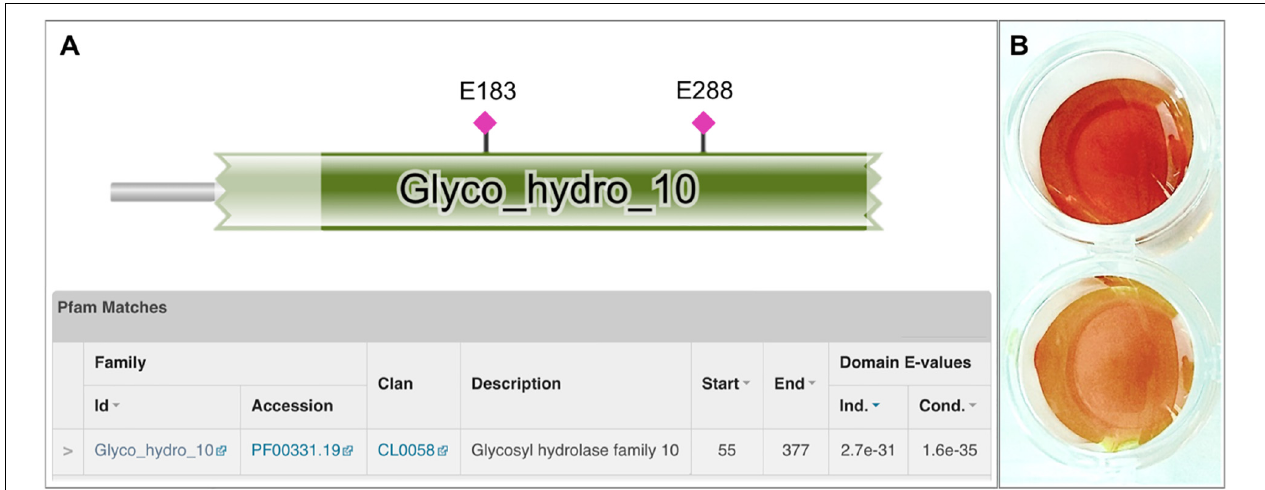
FIGURE 2 | Discovery of the xylanolytic enzyme XynDZ5. (A) The 430-amino acid sequence of the putative xylanolytic enzyme corresponding to the xynDZ5 ORF was analyzed against the Pfam-A database using HHMER. The analysis revealed that the predicted sequence contains a GH10 catalytic domain spanning amino acids 55–377 (green color). Also, the sequence was annotated to the TIM barrel GH superfamily (Clan CL0058), which contains a range of GHs that possess a TIM barrel fold. Two predicted catalytic residues were also detected in the XynDZ5 sequence at positions E183 and E288, as indicated. (B) Detection of xylanolytic activity by DNS assay and xylan as a substrate where the observed color change indicates the release of reducing sugars due to xylanolytic activity. E. coli cell lysates producing XynDZ5 from pASK75- xyn DZ5 gave a positive reaction (upper part), cell lysates of the same bacteria carrying an empty pASK75 vector were used as a negative control